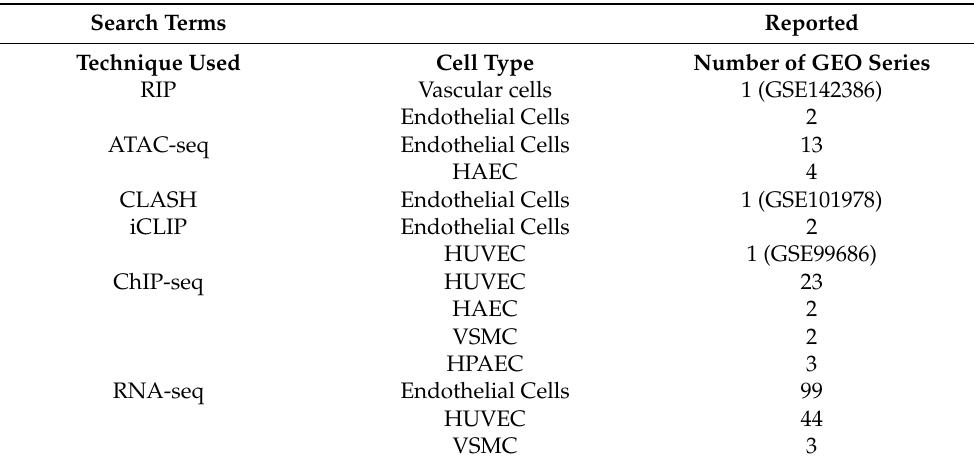
Table 2. Total number of Gene Expression Omnibus (GEO) series reporting the use of named techniques in vascular field between